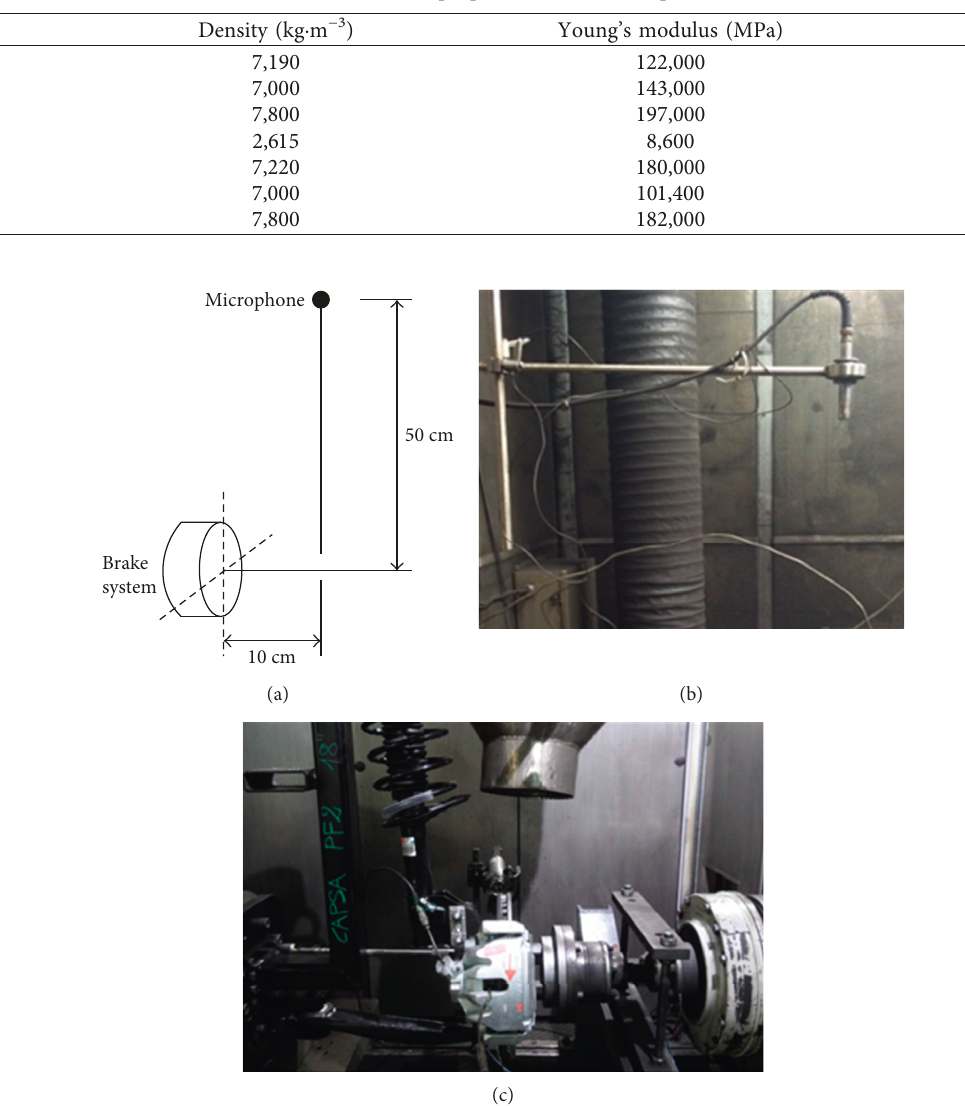
Table 1: Material properties of brake components.